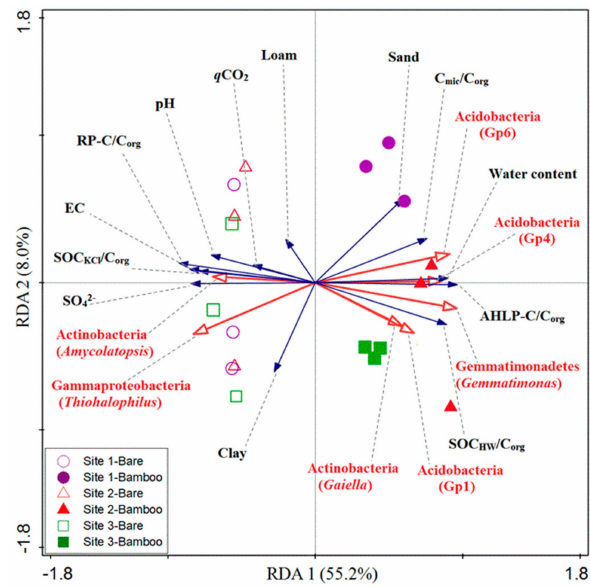
Figure 4. Redundancy analysis on the soil physiochemical properties and soil bacterium community contents in the soils at di ff erent